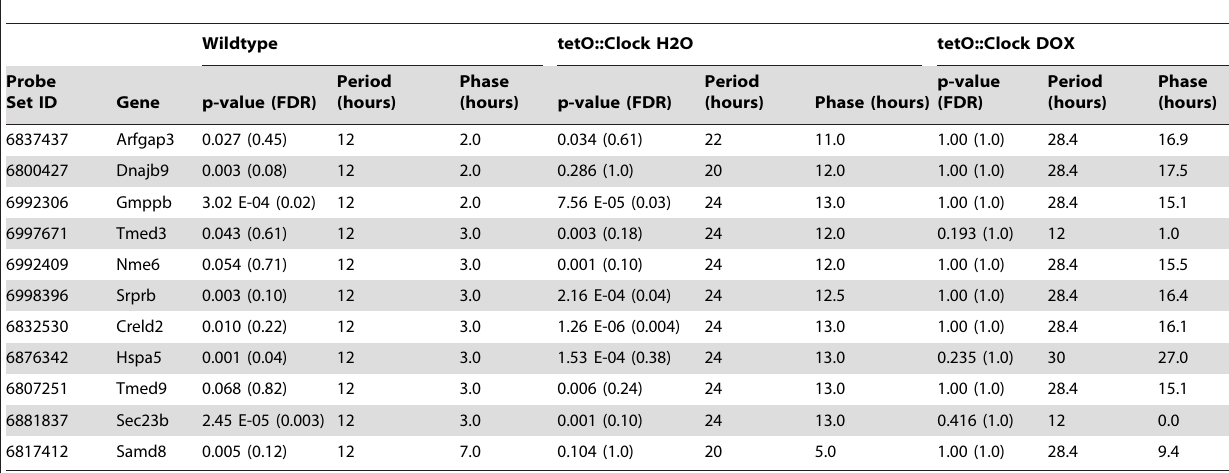
Table 3. 12-hour transcriptional rhythms revert to 24-hour rhythms when Clock is driven in the SCN.